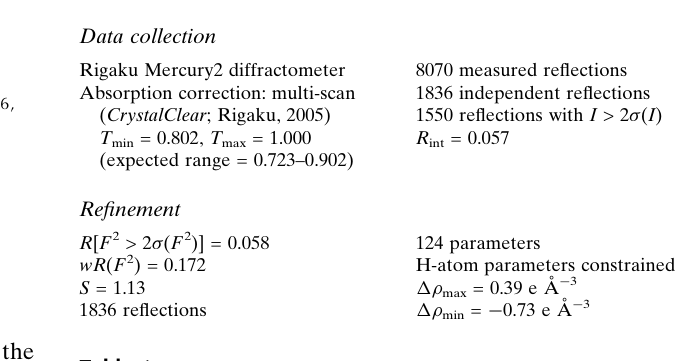
Rigaku Mercury2 diffractometer Absorption correction: multi-scan ( CrystalClear ; Rigaku, 2005) T min = 0.802, T max = 1.000 (expected range = 0.723–0.902)